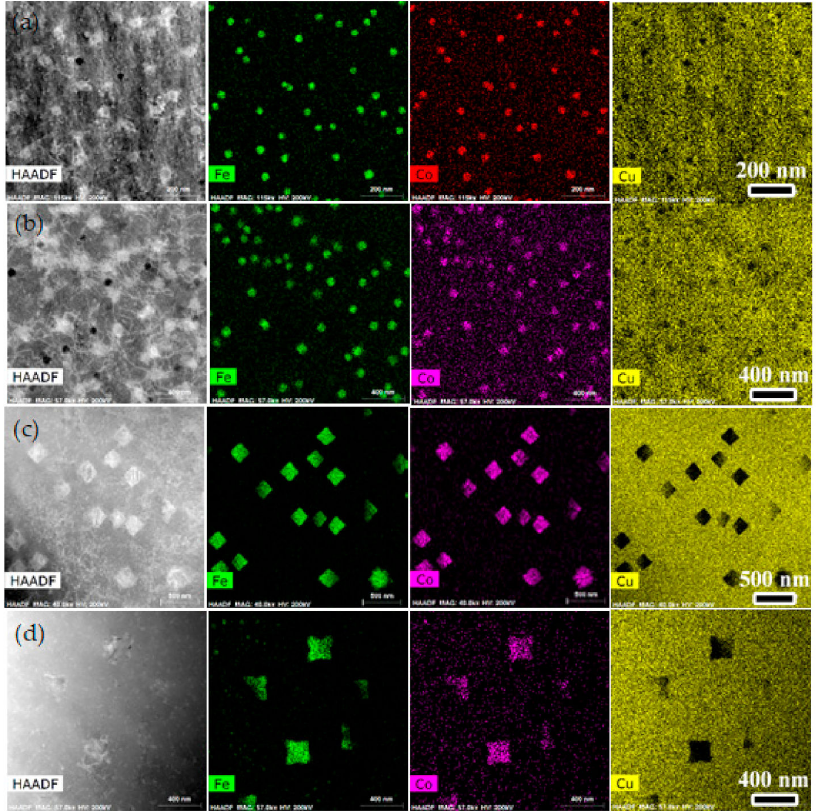
Figure 11. HAADF or BF images of iron-rich nanoparticles and their corresponding elemental maps. ( a ) Spherical nanoparticles in Cu-1.0Fe-0.5Co alloy; ( b ) Spherical nanoparticles in Cu-1.5Fe-0.5Co alloy; ( c ) Petal-like nanoparticles in Cu-2.0Fe-0.5Co alloy; ( d ) Petal-like nanoparticles in Cu-3.0Fe- 0.5Co